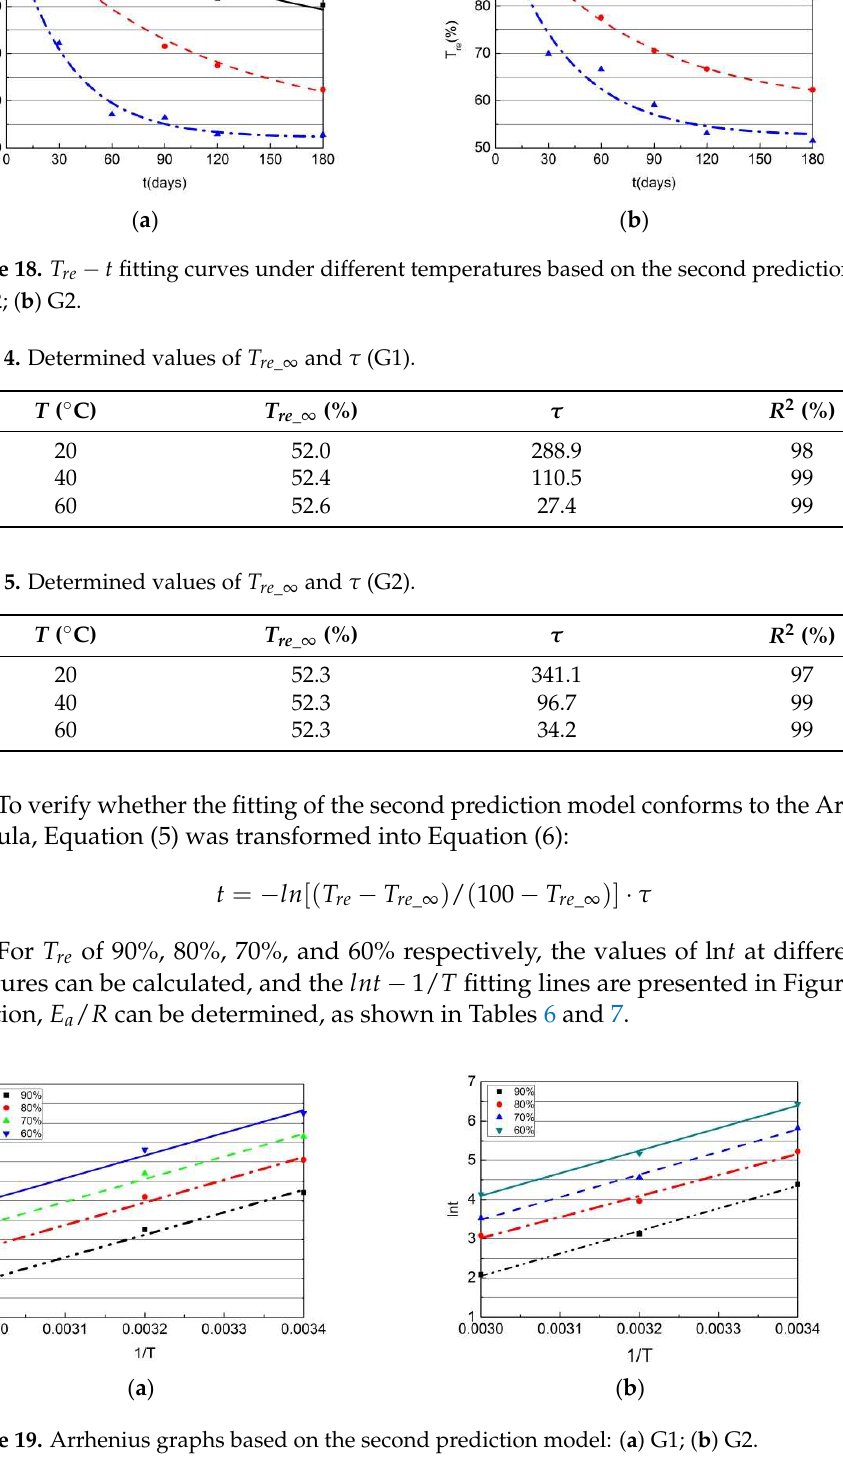
Table 7. Values of 𝐸 (cid:3028) 𝑅⁄ (G2) based on the second prediction model.